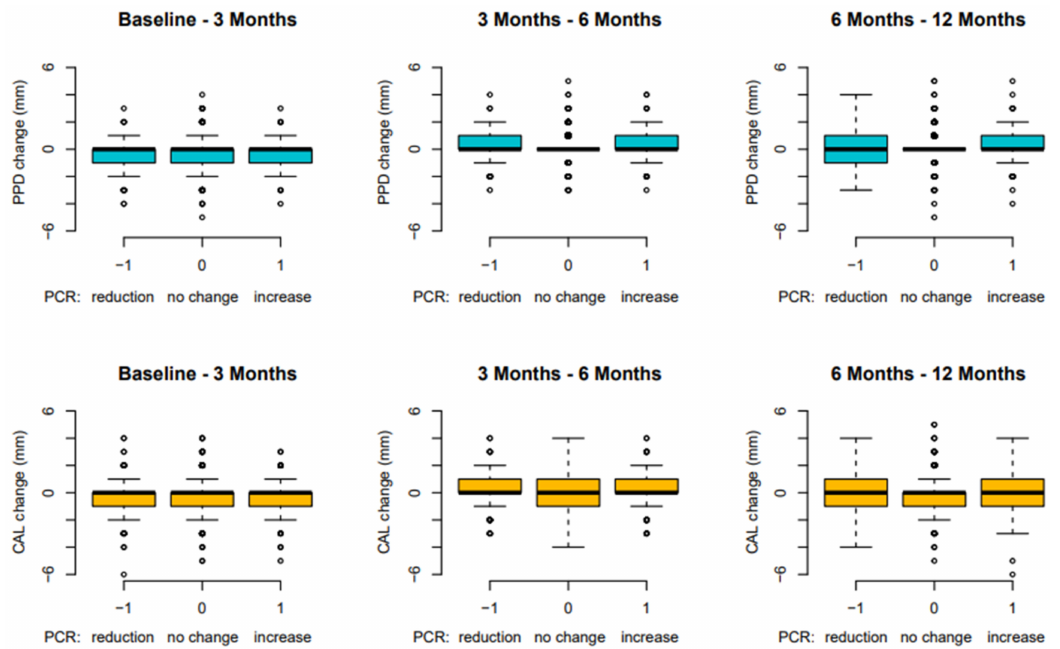
Figure 3. Site-based analysis: PPD and CAL changes in relation to FMPS over 12 months (FMPS: full-mouth plaque score; PPD: probing pocket depth; CAL: clinical attachment